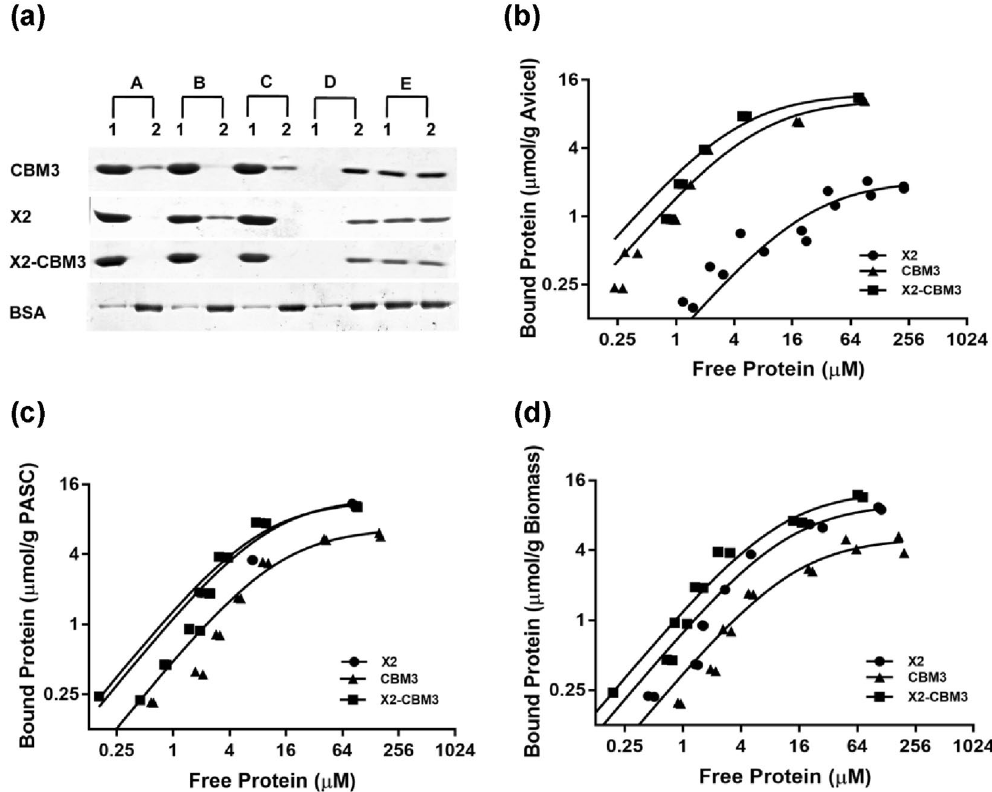
Figure 5. Binding of X2-CBM3 and its independent modules to insoluble polysaccharides. ( a ) 10 μ g of purified protein was incubated with 4 mg of insoluble substrates, such as (A) biomass, (B) Avicel, (C) PASC, (D) starch and bound (1) and unbound * (2) proteins were analyzed on the SDS-PAGE gel. (E) The same amount of protein used in the binding assay in absence of the polysaccharide was included as a control to observe aggregation over the incubation period. Same amount of BSA was allowed to bind to the respective substrates and included as a control. Depletion isotherm of CBM3, X2 and X2-CBM3 proteins binding to ( b ) Avicel, ( c ) PASC and ( d ) biomass. X and Y axis are plotted on log2 scales for representation of data from 2-fold increasing protein concentration. Full-length gels are included as Supplementary Fig. S4. * Only 20 μ l of 250 μ l unbound fraction was loaded on the SDS-PAGE gel.